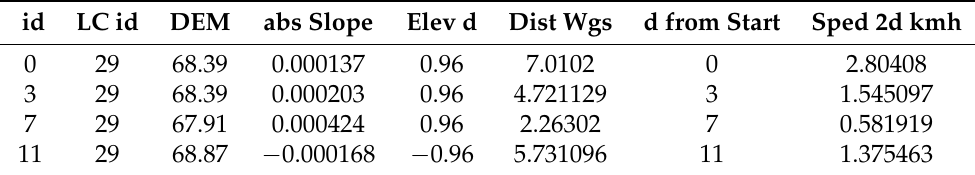
Table 2. A sample of data used for regression model